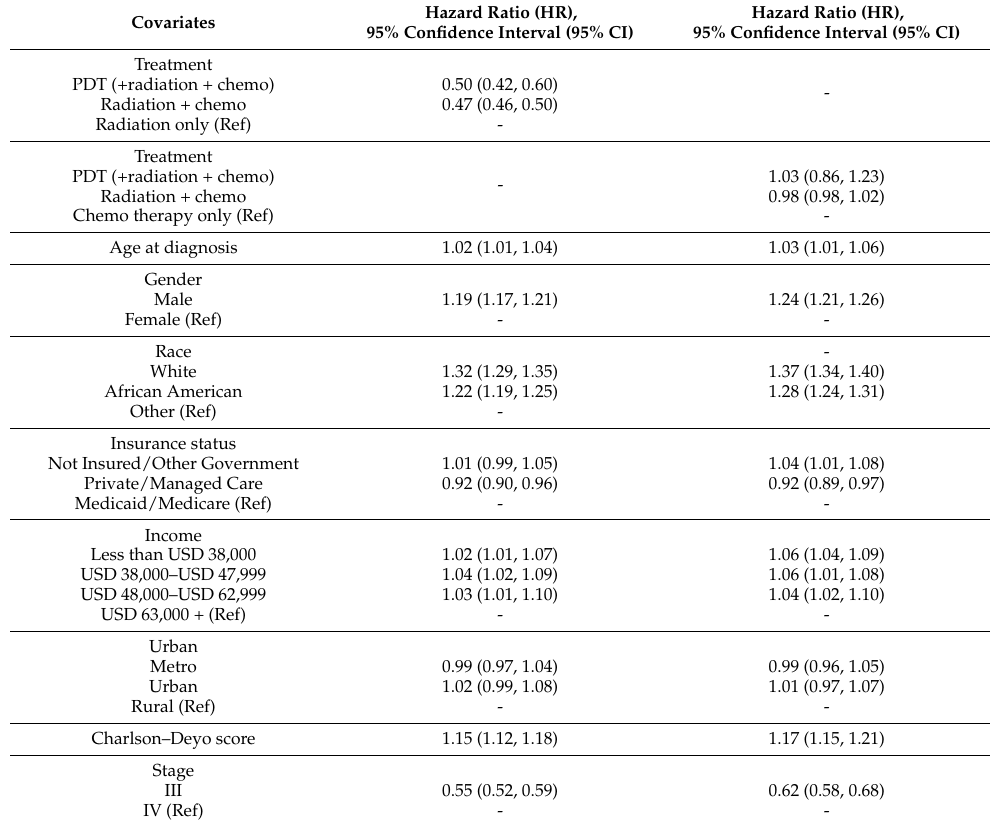
Table 2. Survival analysis stage III and IV (overall survival), propensity score adjusted.